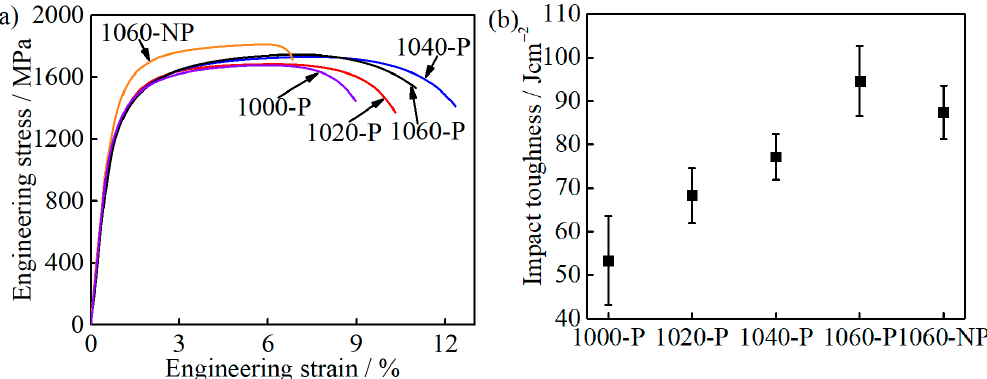
Table 1. Volume fraction of RA, elements (C, Cr) content and the area fraction of M 23 C 6. Table 2. To clarify the difference caused by the austenitizing temperature, the deceiving factors on ductility and impact toughness will be further discussed in the late section.